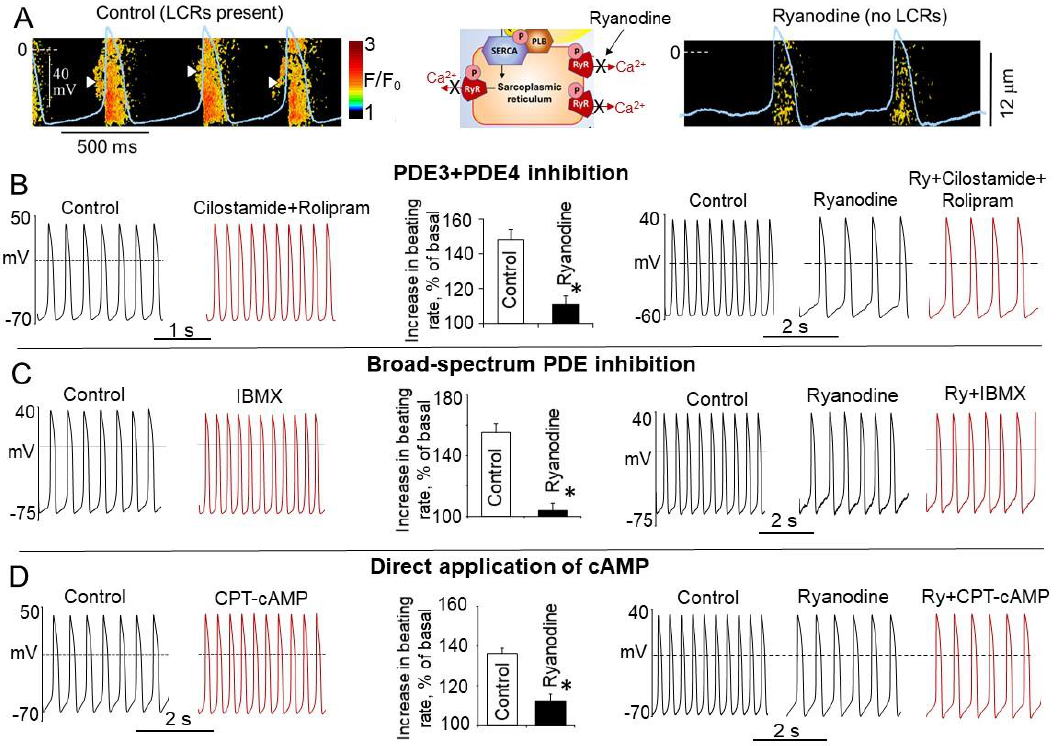
Figure 11. PDE inhibition or direct elevation of (cAMP) in SANC requires intact RyRs function to produce acceleration of the spontaneous beating rate of rabbit SANCs. ( A ) Simultaneous recordings of APs and line-scan images of AP-induced Ca 2+ transients and LCRs in rabbit SANCs in the absence (left) or presence (right) of ryanodine (3 µ mol/L). Suppression of local subsarcolemmal Ca 2+ releases (LCRs) by ryanodine prevents an increase in the spontaneous SANC firing rate by: ( B ) dual PDE3 + PDE4 inhibition (0.3 µ mol/L cilostamide + 2 µ mol/L rolipram) (control (n = 4 SANC); ryanodine (n = 7 SANC) t -test, * p < 0.05, from [11]) or ( C ) by broad-spectrum PDE inhibitor 100 µ mol/L IBMX (control (n = 10 SANC); ryanodine (n = 4 SANC) t -test, * p < 0.05) or ( D ) by direct increase of intracellular cAMP by 300 µ mol/L CPT-cAMP (control (n = 4 SANC); ryanodine (n = 7 SANC) t -test, * p < 0.05; modified from [40]), see text for